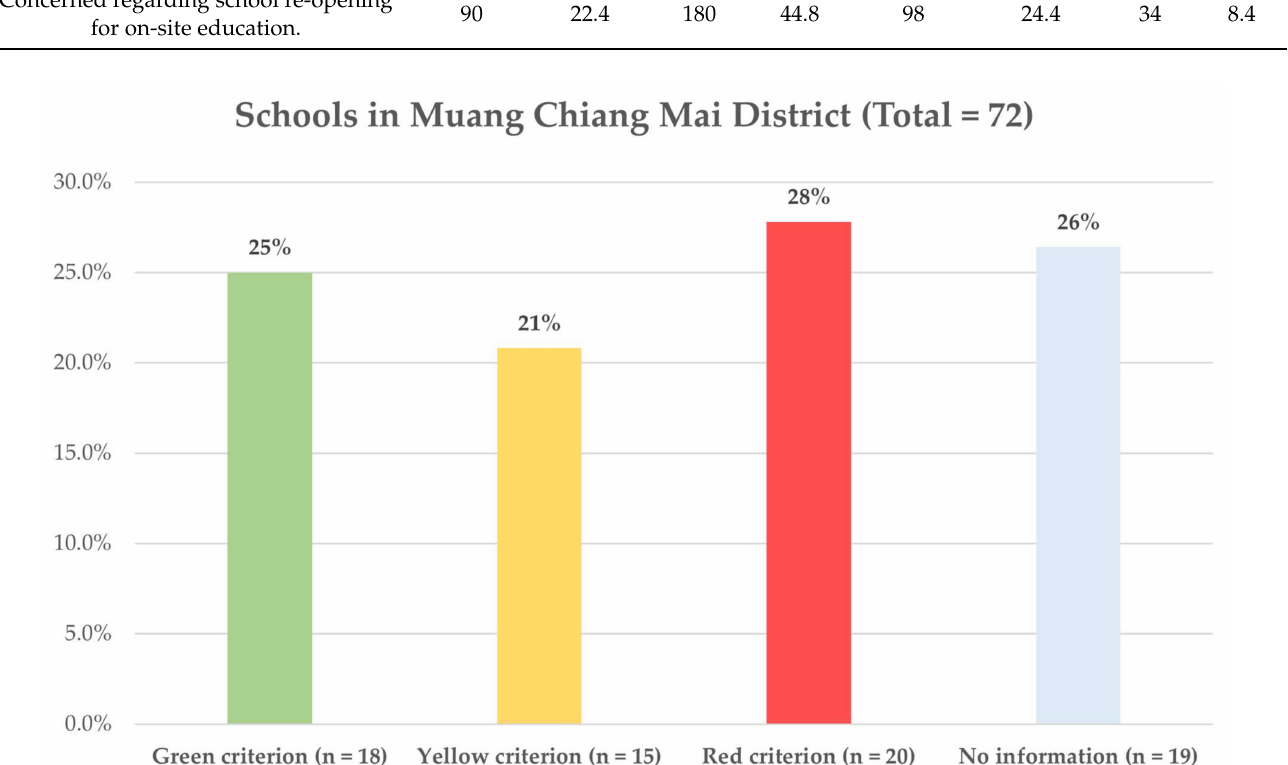
Figure 2. Proportion of schools in the urban district of Chiang Mai which meet the criteria recom- mended for the re-opening of on-site education. Green criterion, All primary or secondary dimensions are actionable; Yellow criterion, All primary dimensions and some of secondary dimensions are actionable; Red criterion, No primary or secondary dimensions